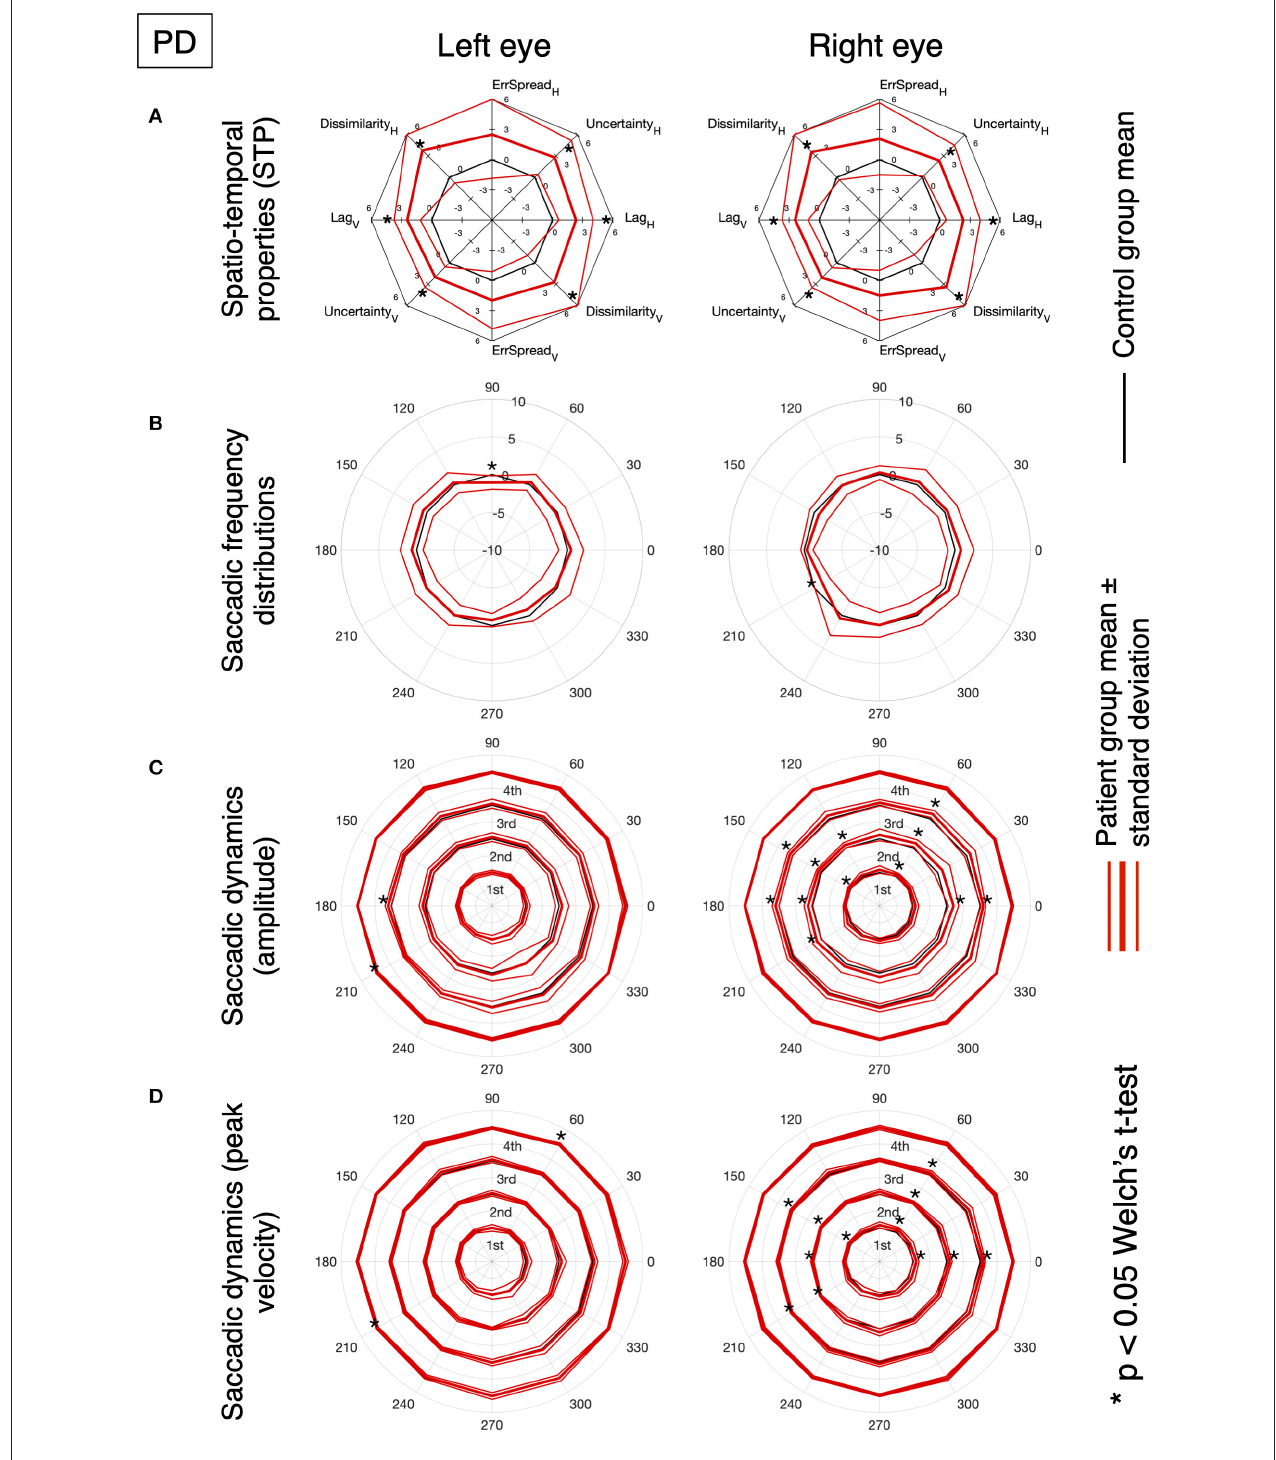
FIGURE 6 | Same as Figure 5 .